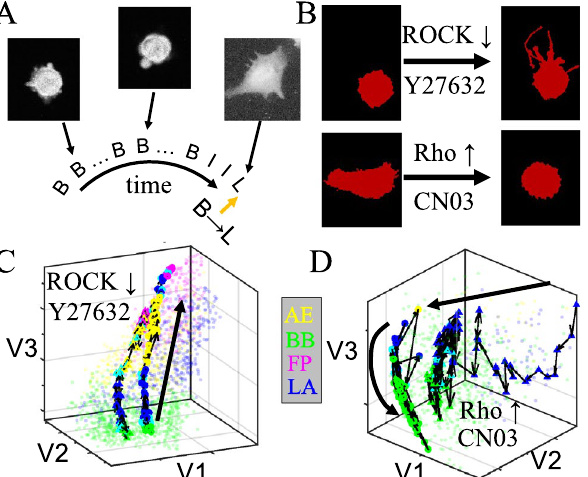
Figure 3. Rho/ROCK-signaling internally controls mesoscale morphodynamics of 3D cultured MDA-MB-231 cells. ( A ) A sample time series of morphological phenotype. Insets: three snapshots showing the GFP-labeled cell morphology. Abbreviations: B—blebbing, I—intermediate state, L—lamellipodial. ( B ) Representative morphological changes under treatment of Y27632 and CN03, which downregulates and upregulates Rho/ ROCK signaling respectively. ( C , D ) Characteristic morphodynamic trajectories of cells in the t-SNE embedded shape space. The trajectories start immediately after introducing Y27632 or CN03, and ends after 12 h of incubating with the drugs. The forward time directions are shown as thick curves with arrows as guide to the eyes. Two representative trajectories (one with circular symbols, and another one with triangular symbols) per each treatment are shown as colored symbols connected by black lines, where color represents the instantaneous phenotype. Unconnected light-colored dots show training sets which are the same as in Fig. 2C. Note that to better visualize the 3D trajectories, coordinates have been rotated with respect to Fig. 2C. This figure is prepared with Matlab R2020a (www. mathw orks. com) and ImageJ (https:// imagej.